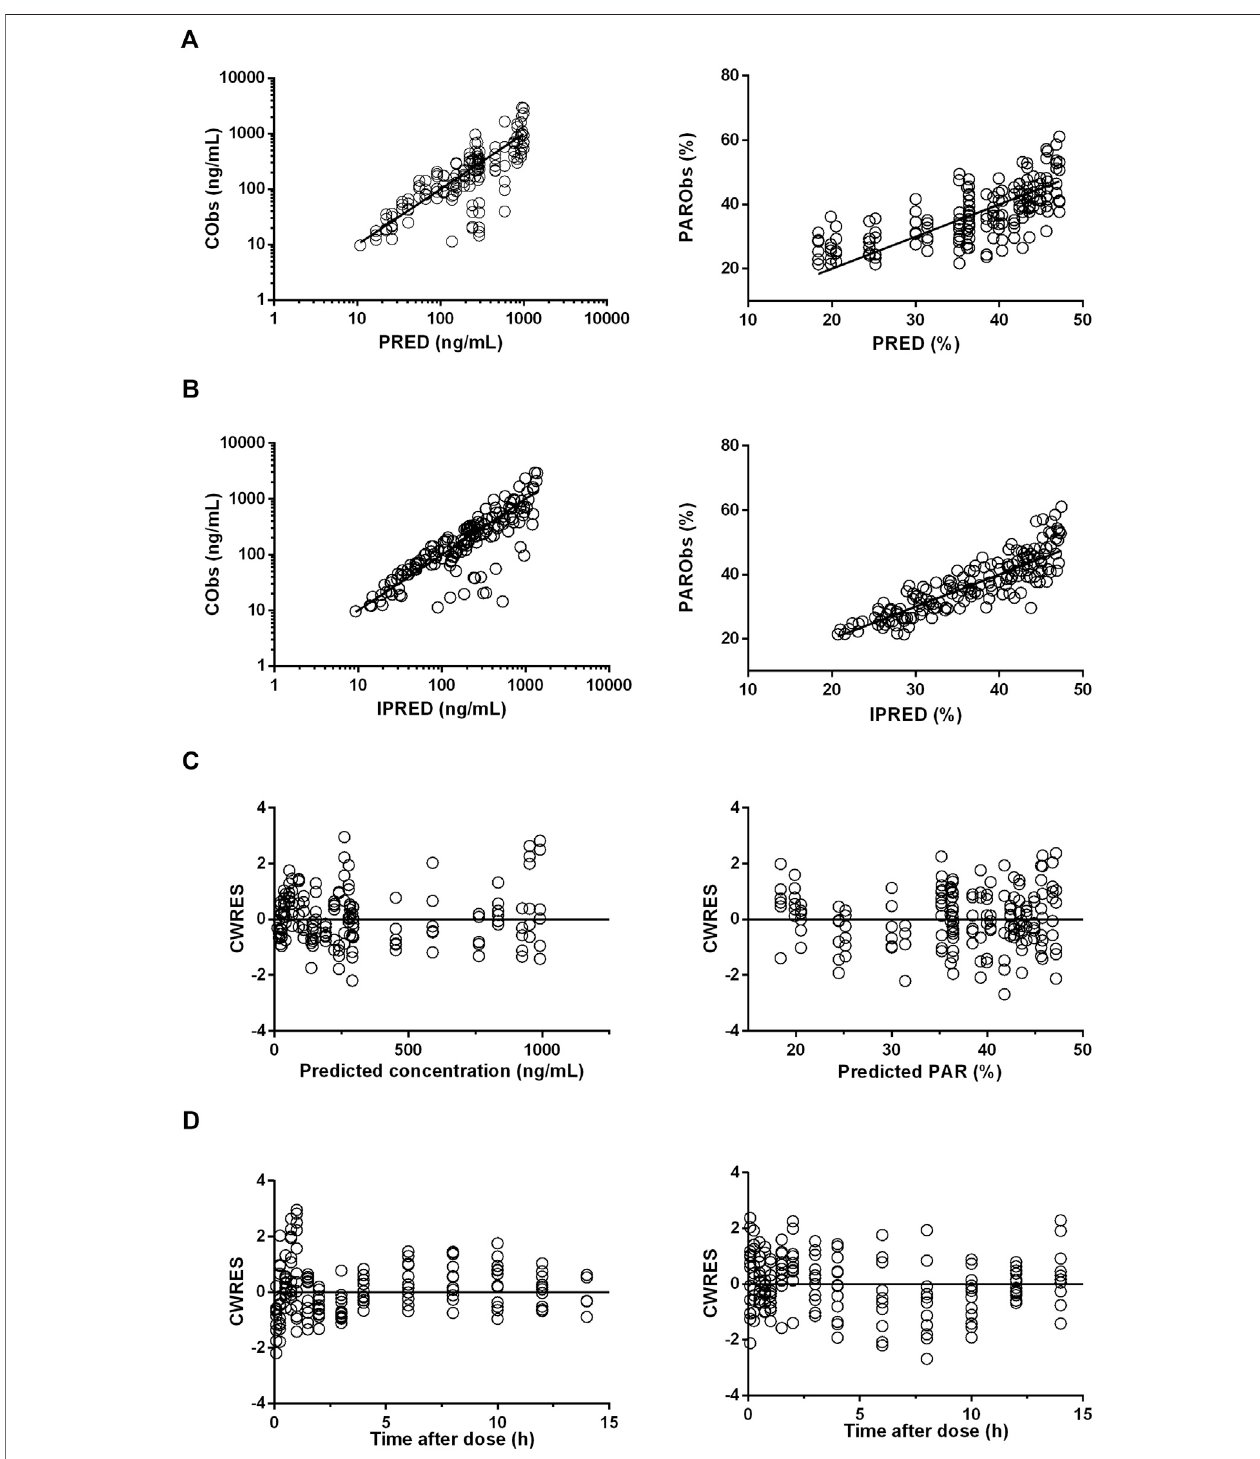
FIGURE4| Diagnostic plotsforpharmacokinetic(PK)(left panels) and pharmacodynamic (PD)(rightpanels) pro fi le estimations. (A) ,The observed values(Obs)vs. population predicted values (PRED). (B) , The observed values vs. individual predicted values (IPRED). (C) , CWRES vs. population predictions. (D) , CWRES vs. time after dose.